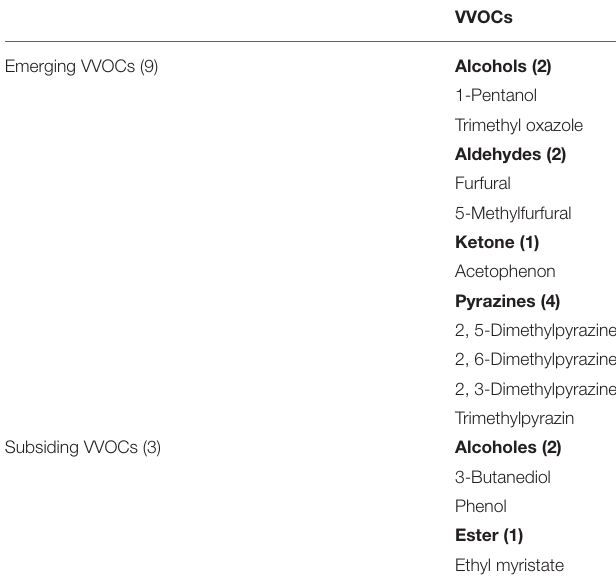
TABLE 6 | Emerged and disappeared VOCs in SAV after heating 6 days at 85 ◦